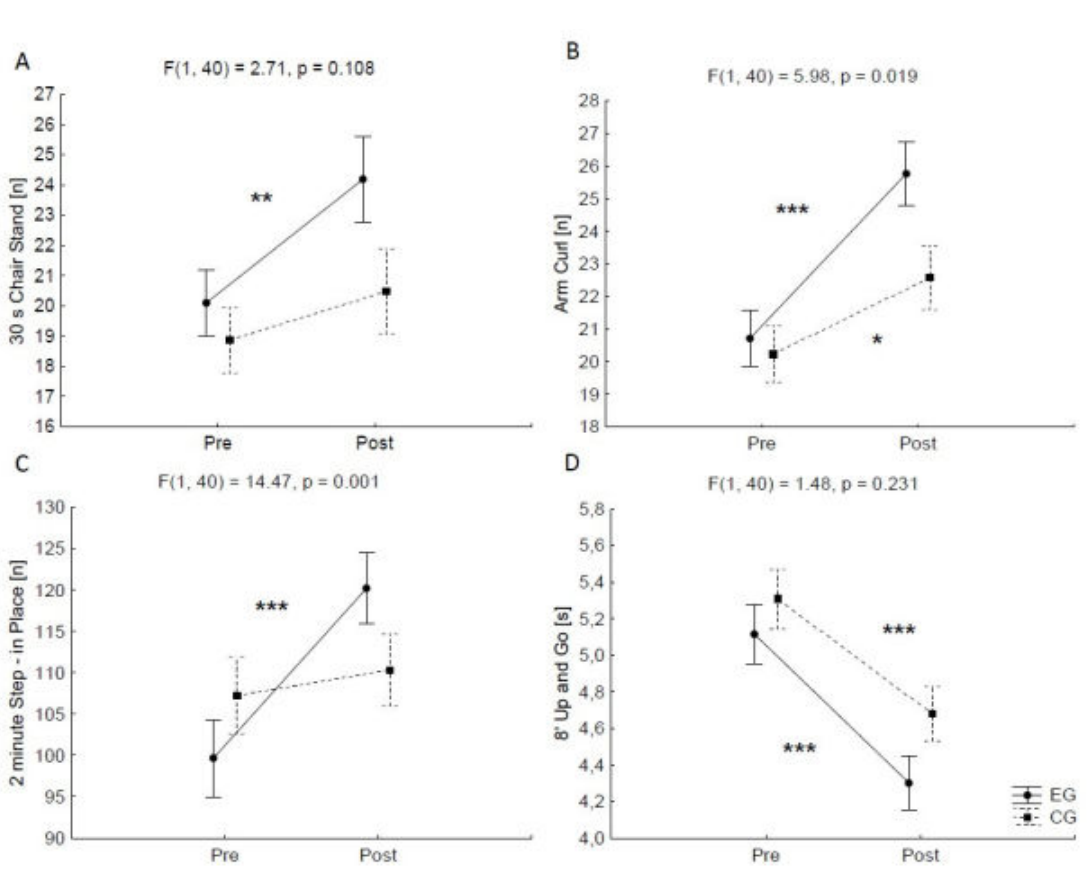
Figure 4. Mean values and standard error of measurements for 30-second chair stand, arm curl, 2-minute step in place and 8-foot up and go tests (( A – D ), respectively) for the “time” factor (pre–post) in the experimental and control groups (EG and CG, respectively).* p < 0.05, ** p < 0.01, *** p < 0.001 (Sche ff e post hoc